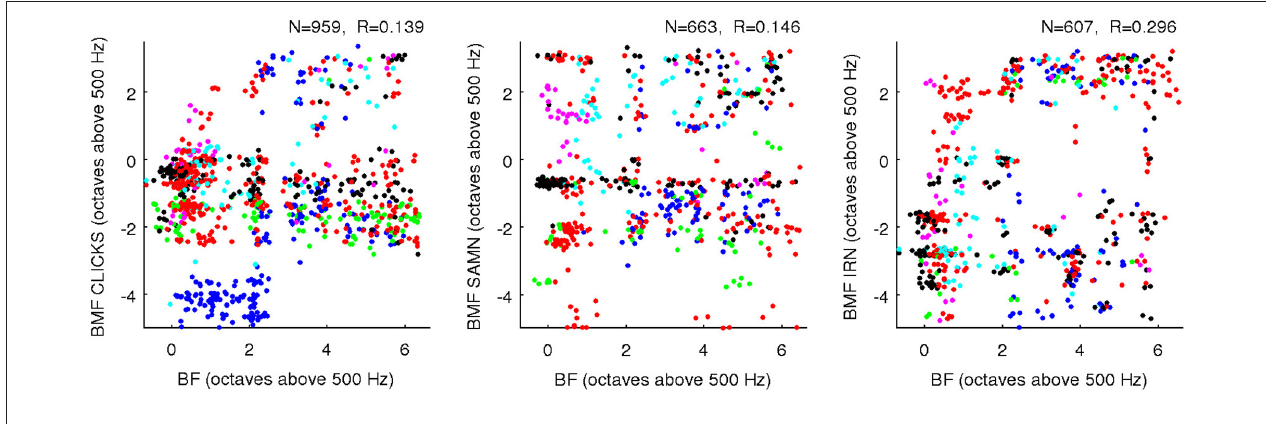
Gaussian distributed jitter with a standard deviation of 0.09 octaves has been added to the rBMF values to spread out overlapping data points. The number of multiunits in each data set ( N ) and correlation coefficient ( R ) are shown above each panel.